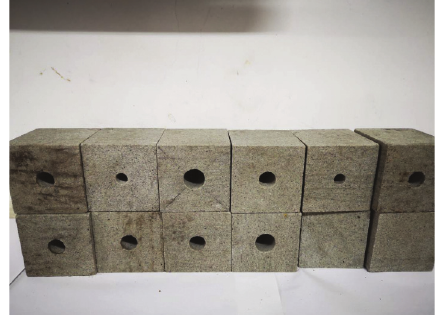
Figure 3: Actual pretreatment of rock